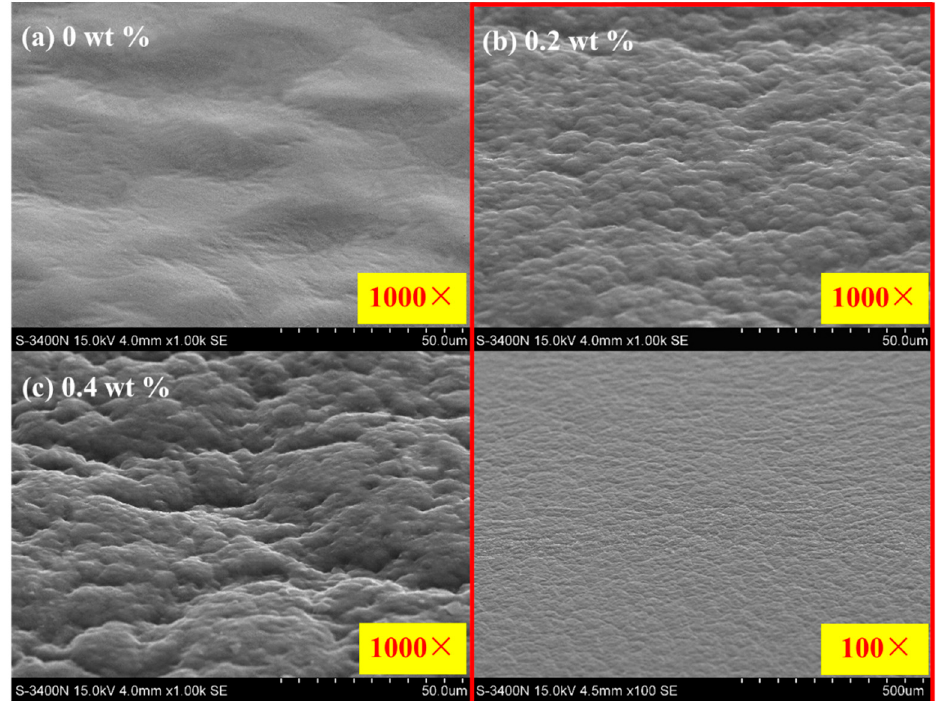
Figure 4. The images of the tilted low gloss acrylic polymer films at 60° angle with crosslinker AMA contents ranging from ( a ) 0 wt %, 1000× to ( b ) 0.2 wt %, 1000× or 100× and to ( c ) 0.4 wt %, 1000×, respectively.